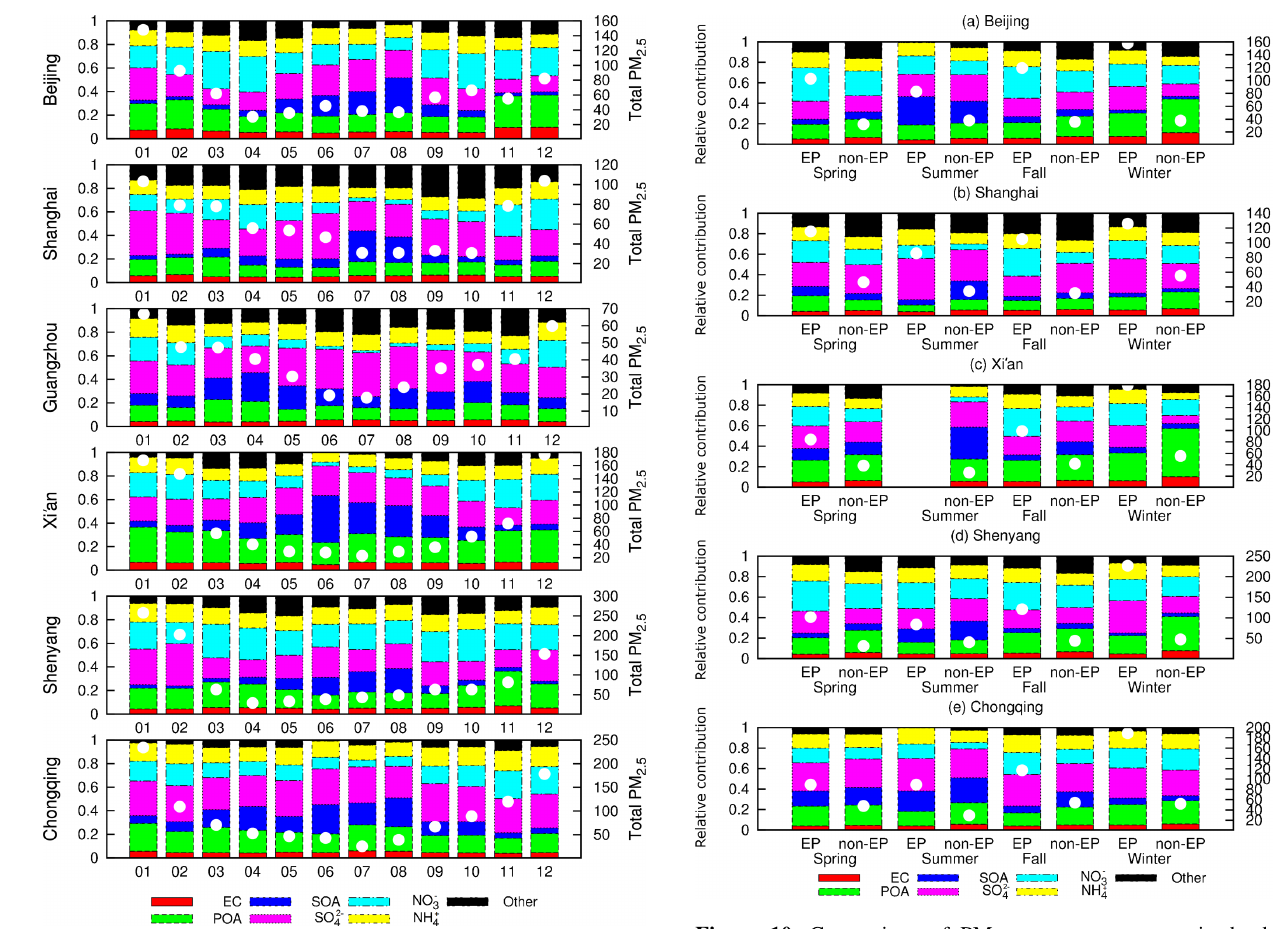
Figure 9. Contributions of different components to monthly aver- aged PM 2 . 5 concentrations at selected cities in China. White circles are absolute concentrations according to right y axis with unit of µgm − 3 .